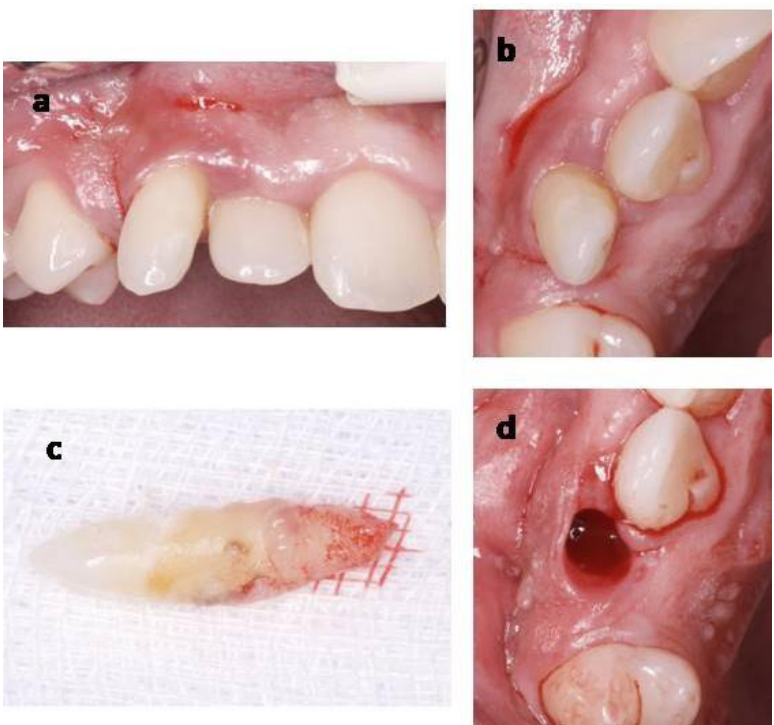
Figure 6. Temporary canine extraction (Case 2). ( a ) Buccal photography of temporary canine. ( b ) Occlusal photography of the temporary canine. ( c ) Extracted temporary canine. ( d ) Extraction socket.